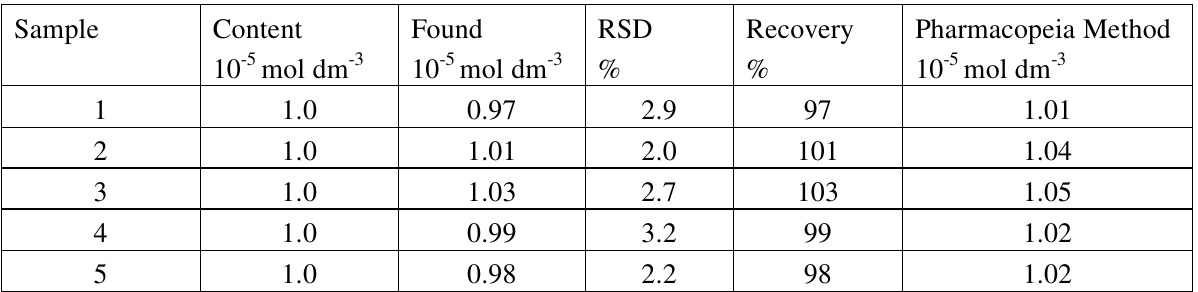
Table 1. Results of DA analysis in injections ( n=10)